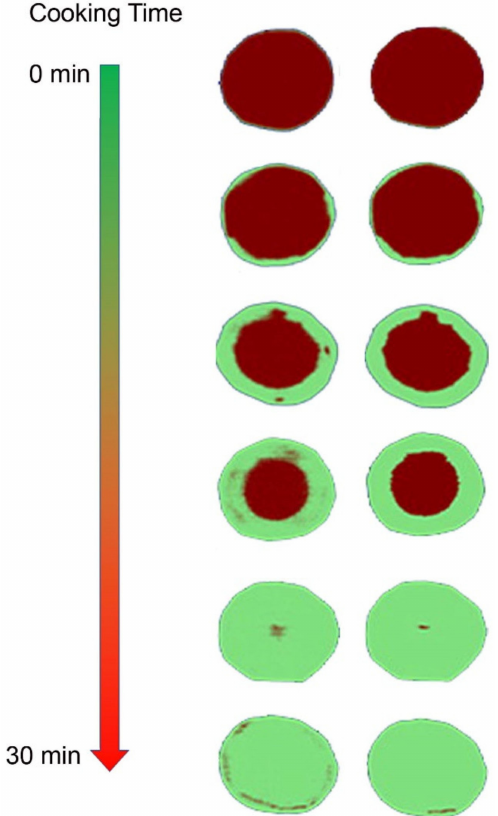
Figure 7. Partial least squares discriminant analysis images of potatoes with different cooking times predicted (modified from